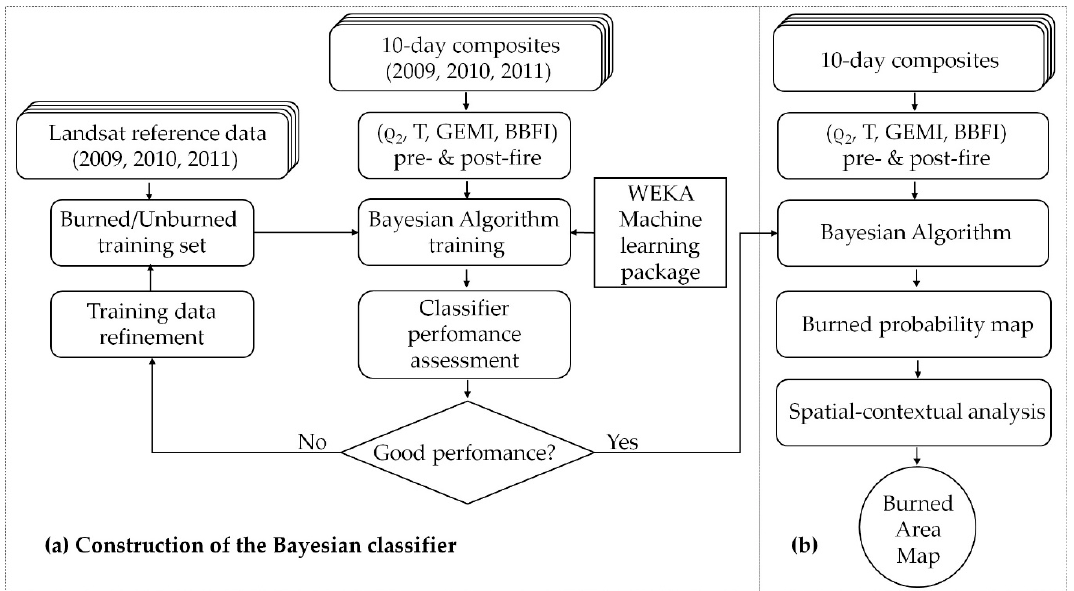
Figure 2. Flowchart with the iterative design process of the Bayesian algorithm ( a ) and its application later to obtain annual maps of burned area ( b ).